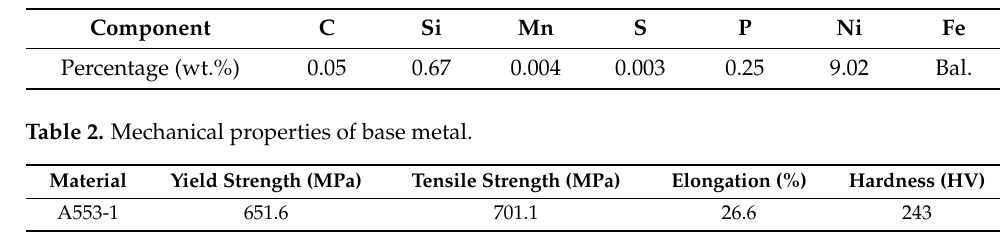
Figure 2. The fiber laser welding process. Table 1. Chemical composition of base metal.